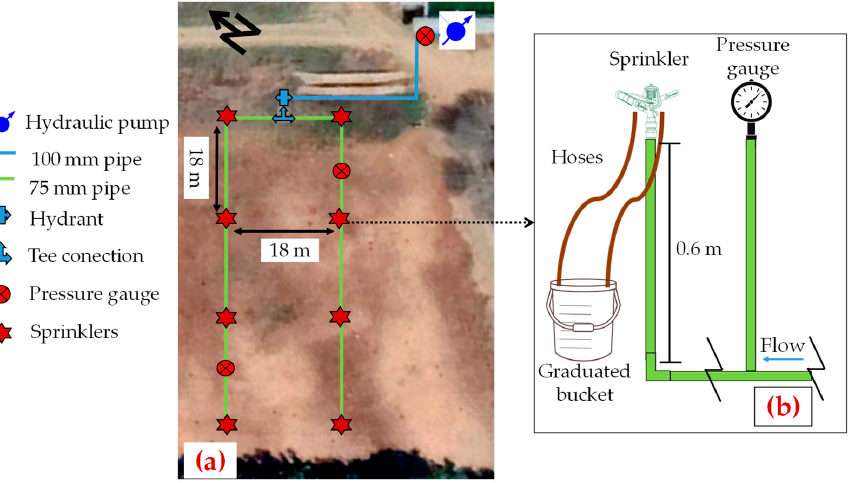
Figure 1. Experimental setup for measuring water application rate ( a ) of individual sprinkler ana- lyzed and its accessories ( b